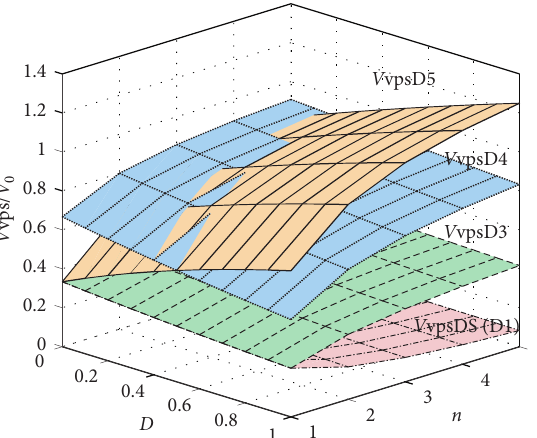
Figure 7: The relationship between the voltage stress of switches, diodes, the turns ratio n , and the duty cycle D.